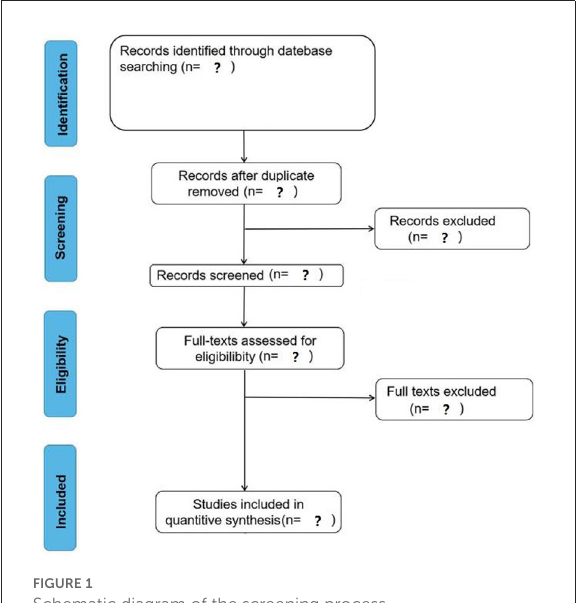
FIGURE1 Schematic diagram of the screening